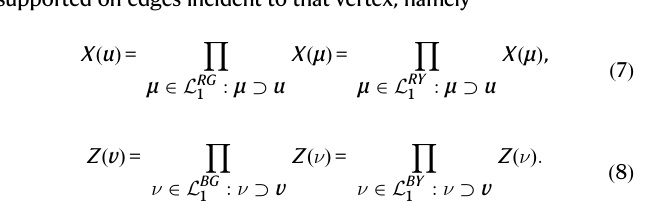
Fig. 6 | Graphs used in decoding the 3D STC. For the 3D STC de fi ned on a colorable octahedral lattice L we construct a the measurement graph G mea and b thequbitgraph G qub .Weuse G mea and G qub inthesingle-shotMWPMdecoderfor syndrome estimation and ideal MWPM decoding, respectively. c An example of a